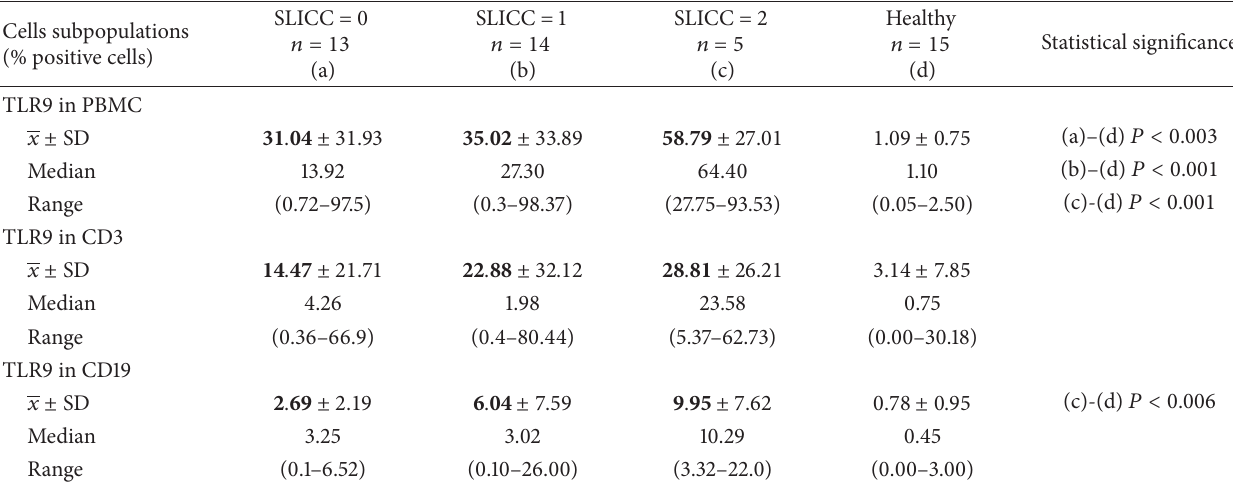
Table 3: The percentage of TLR9-positive PBMCs, lymphocytes B CD19 + , and lymphocytes T CD3 + in relation to SLICC/ACR organ damage. Cells